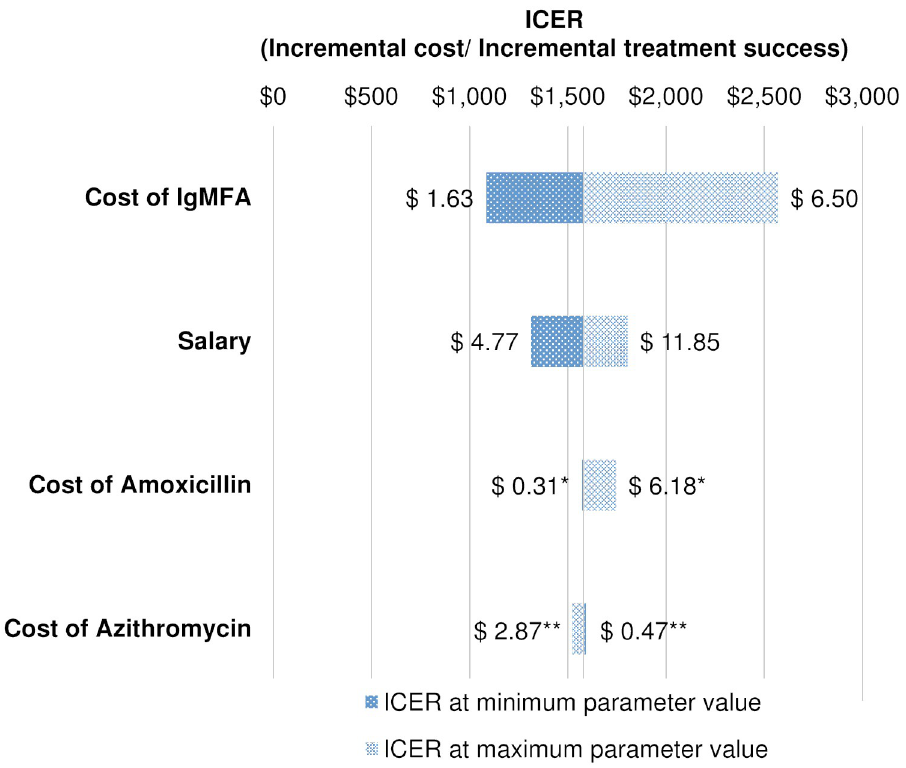
Fig 2. Tornado diagram of ICER change by varying cost parameters. � Cost of amoxicillin is a total cost of 1500mg/ day, 5 days course, including 10% supply cost. �� Cost of azithromycin is a total cost of 250mg/day, 5 days course, including 10% supply cost. ICER, Incremental Cost-effectiveness